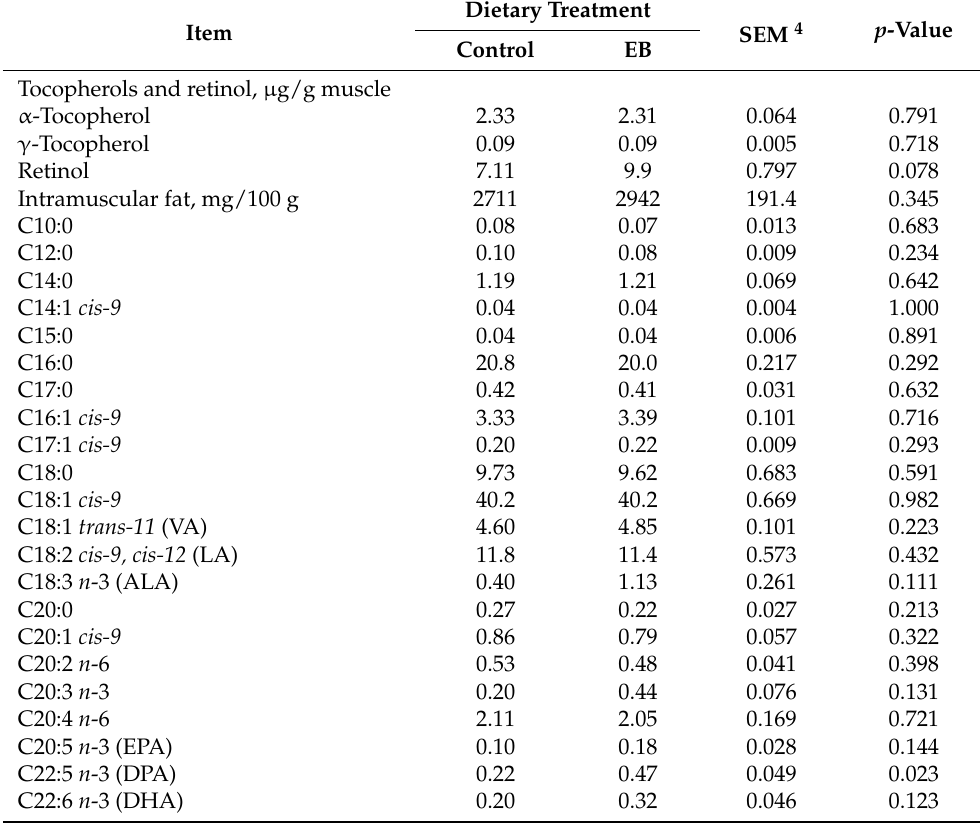
Table 4. Effect of the dietary treatments on the oxidant vitamins ( µ g/g muscle) and fatty